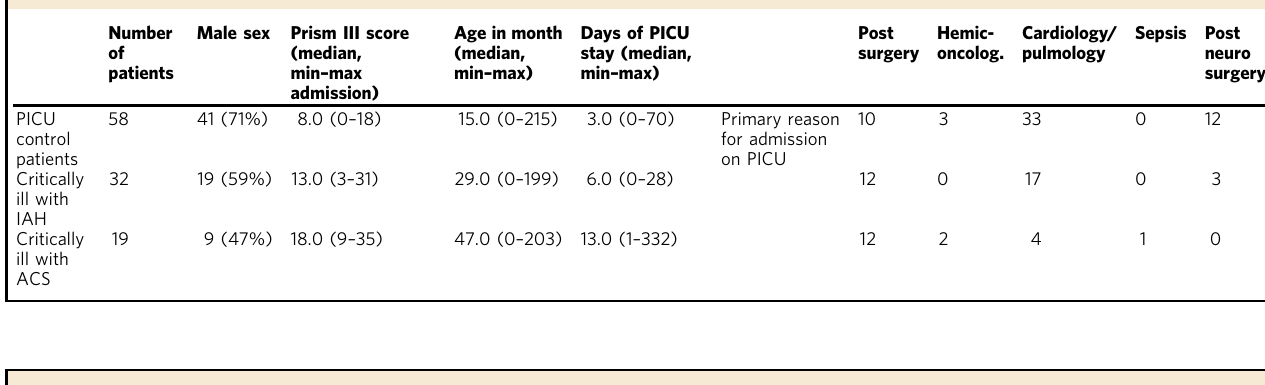
Table 2 Correlation between RGM-A and risk of mortality in